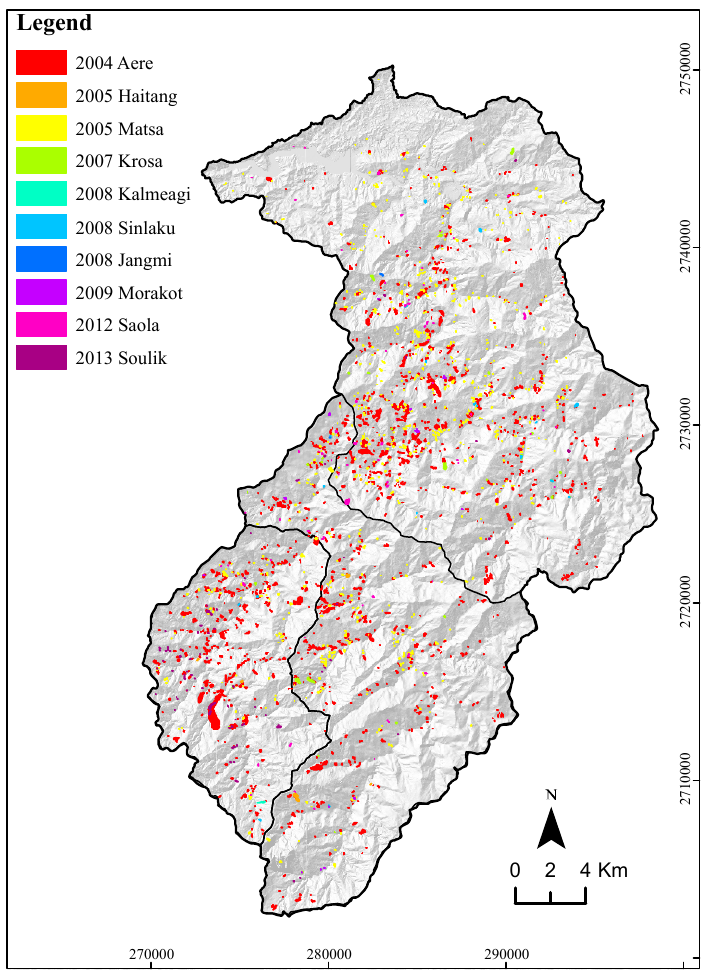
Figure 2. Landslide inventory in the 10 typhoon events in Shihmen Reservoir watershed. Solid black lines denote the watersheds of interest for calibration and